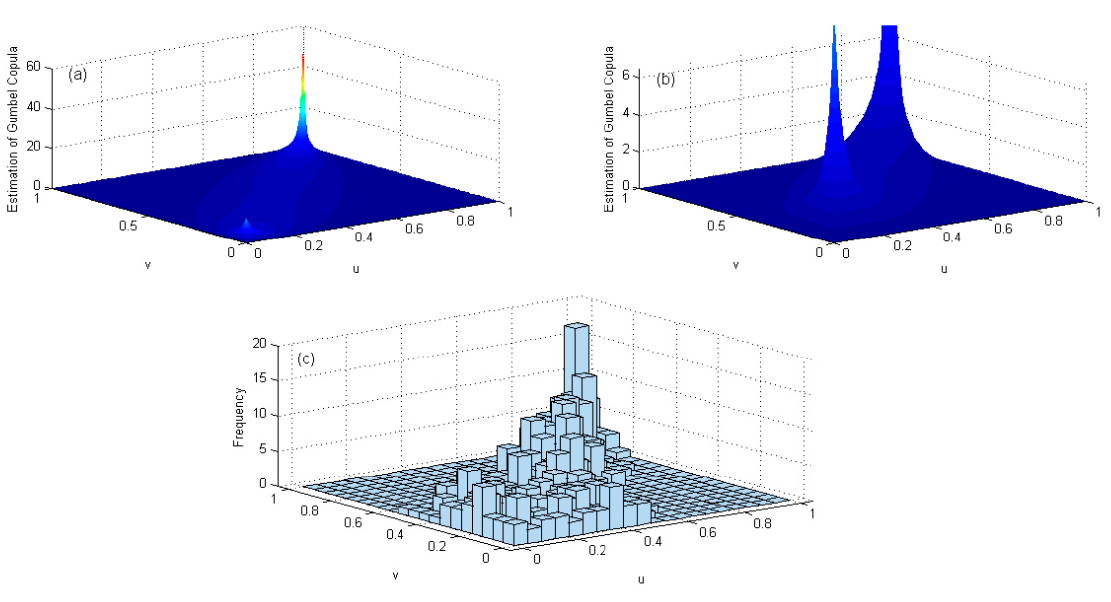
Figure 7. The fitted Gumbel density surface and the histogram of the standardized discharge-precipitation pairs. ( a ) The Gumbel density surface with vertical axis range 0 to 60, ( b ) the Gumbel density surface with vertical axis range 0 to 6.5, ( c ) the histogram of the sample pairs after standardization.